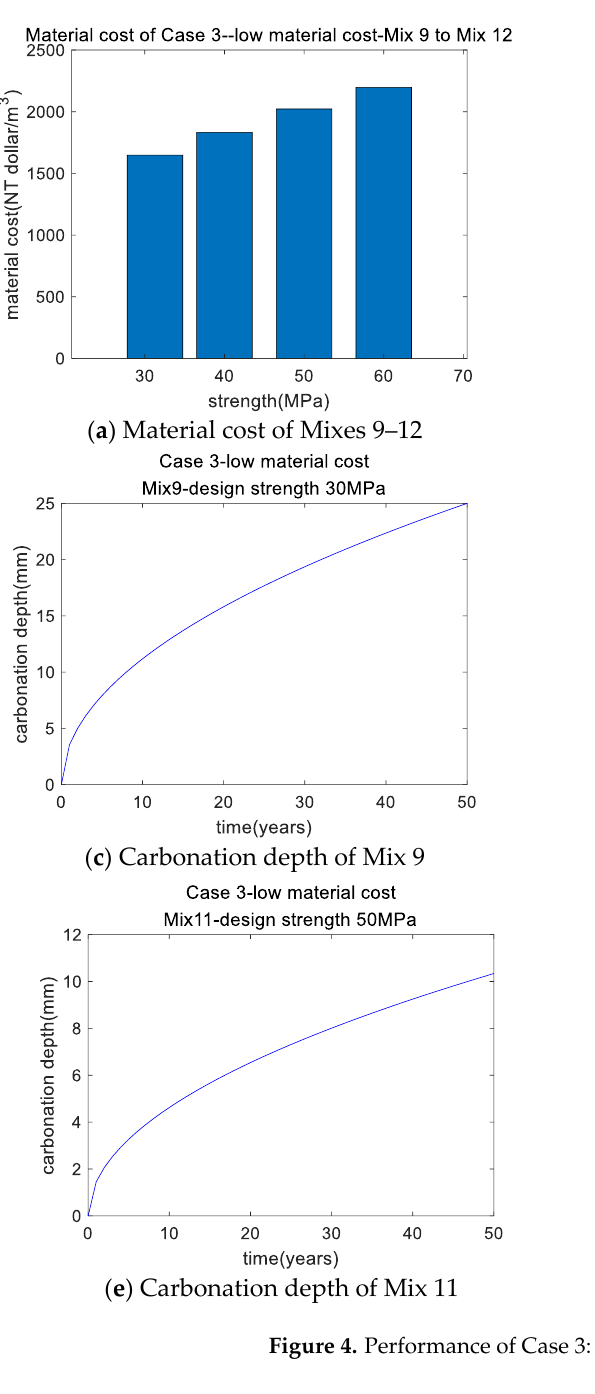
( b ) Total cost versus strength for Mixes 13 – 16 Figure 5. Performance of Case 4: Mixes 13 – 16 (low total cost).